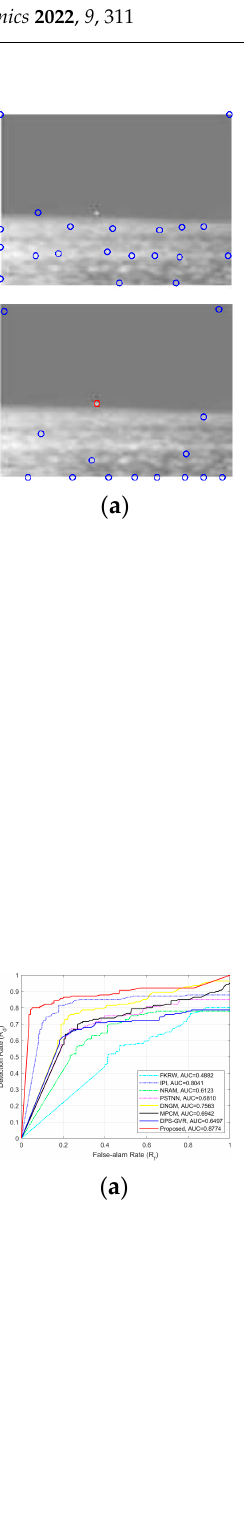
Table 5. Average running time (s) of different methods.